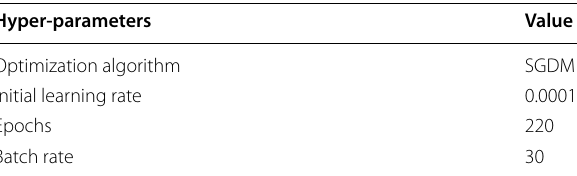
Table 3 Parameters of the stochastic gradient descent with